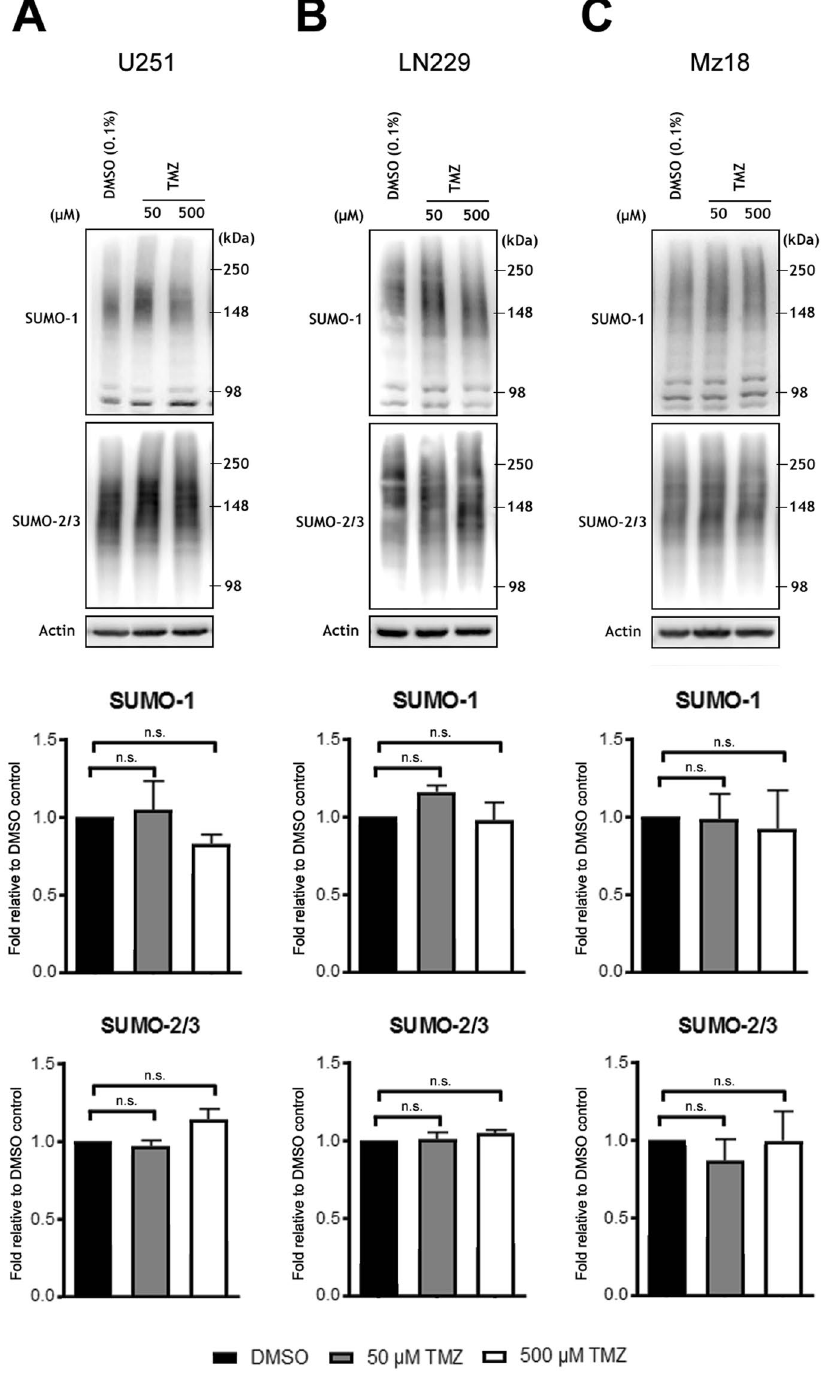
Figure 2. Temozolomide does not decrease global levels of SUMO-conjugation in human GBM lines. U251 ( A ), LN229 ( B ), and Mz18 ( C ), at concentrations of 50 μ M and 500 μ M. Representative immunoblots are shown. High molecular weight ( > 100 kDa) SUMO-1 and SUMO-2/3 conjugates were cropped in each lane and the total intensities were measured. Densitometries were normalized to corresponding actin levels and expressed as a fold difference relative to the control (DMSO). Data are means ( ± SD) from n = 3 independent